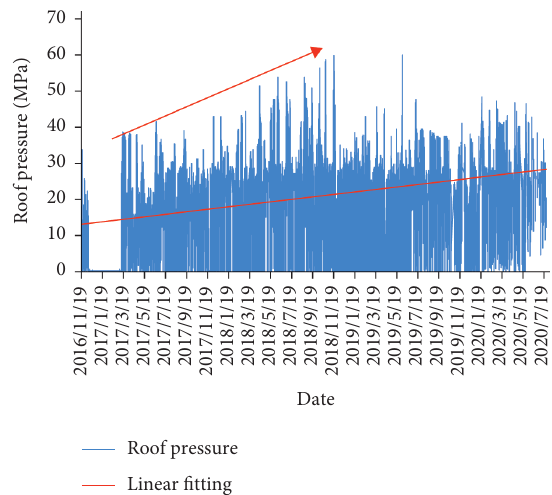
Figure 11: Variation of roof pressure in 13230 face